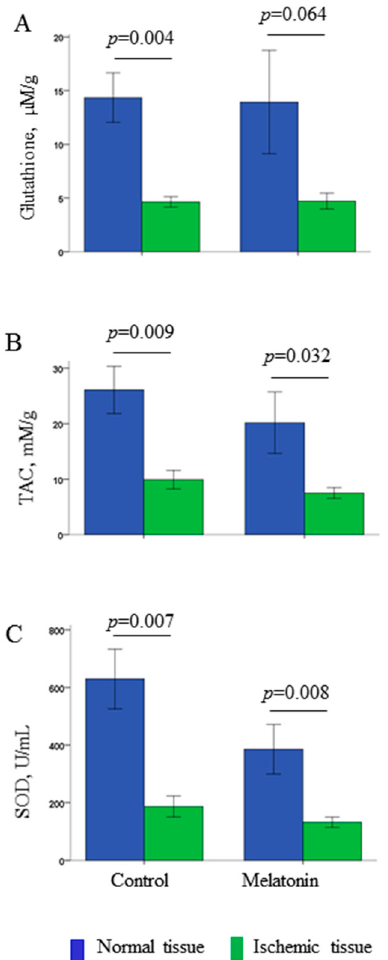
Figure 3. Interregional differences in the parameters (mean ± SEM) of redox state: total glutathione content (panel A ), total antioxidant capacity (TAC, panel B ), and superoxide dismutase activity (SOD, panel C ). No differences between the control and melatonin-treated animals were found, and the ischemia-related changes were similar in the two groups.